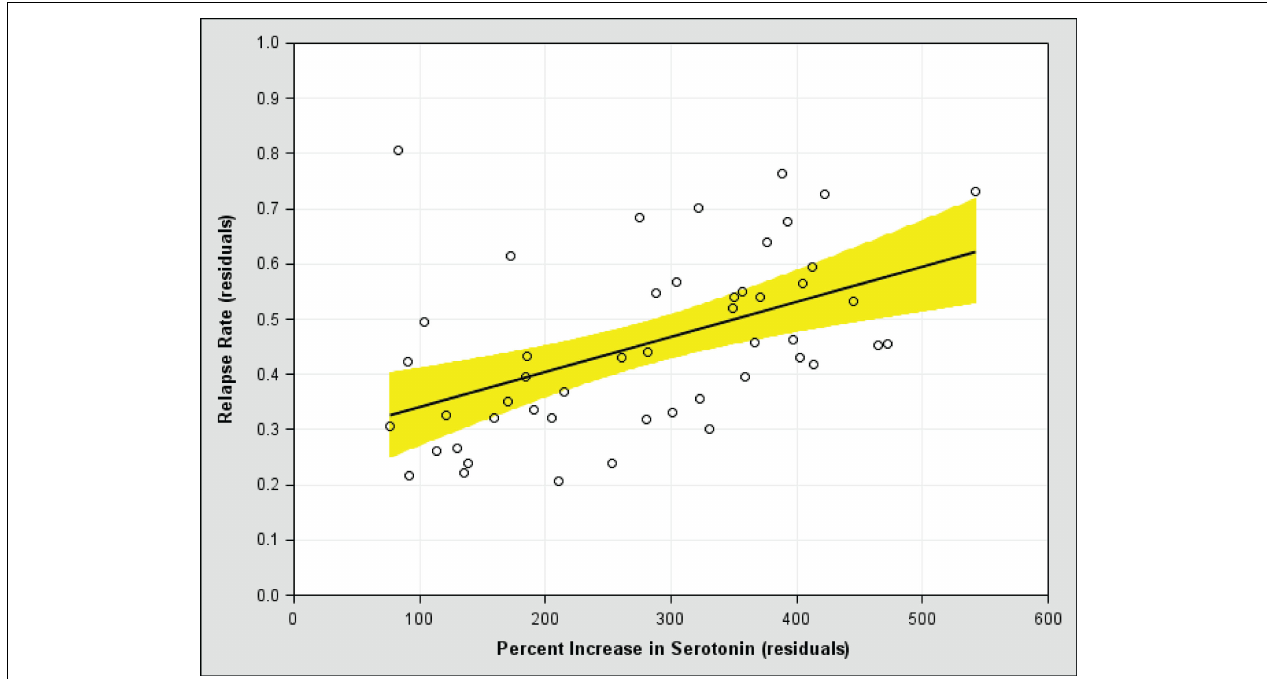
FIGURE 2 |The risk of relapse after antidepressant discontinuation ( y -axis) versus the perturbational effect of antidepressants on serotonin in the rodent medial prefrontal cortex ( x -axis), after controlling for covariates. A score of 100 on the x -axis means the antidepressant has no effect on serotonin